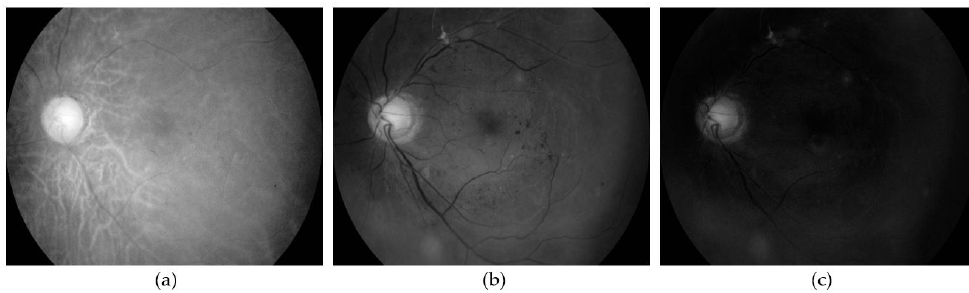
Figure 3. The appearance of fundus image in three separate color channels. ( a ) the red channel; ( b ) the green channel; and ( c ) the blue channel. The blood vessels appear more evident in the green channel.